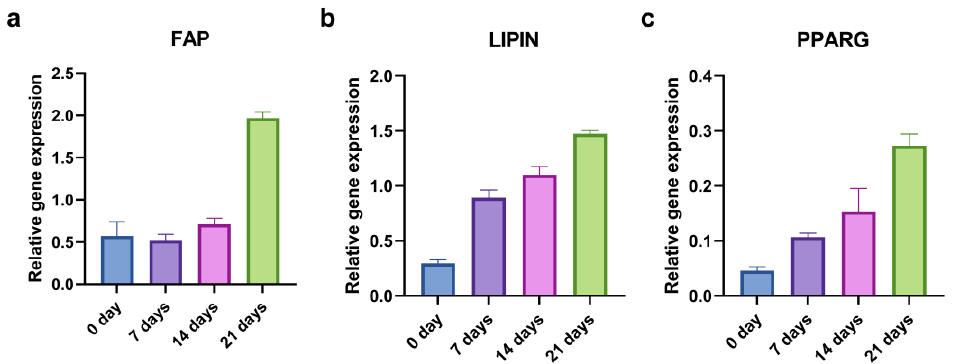
Figure 8. qPCR analysis of relative gene expression of adipogenic markers during 21 days of adipo-induction. FAP ( a ), LIPIN ( b ), and PPARG ( c ) relative expression levels in CD44 + cells.